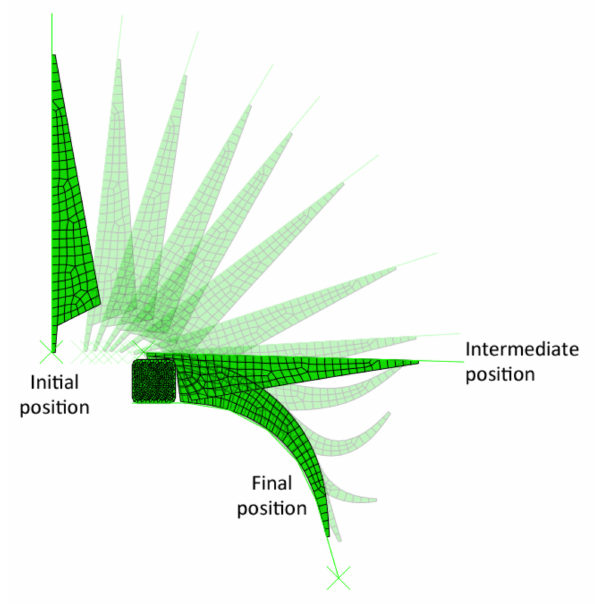
Figure 8. Simulation of the apexing process.